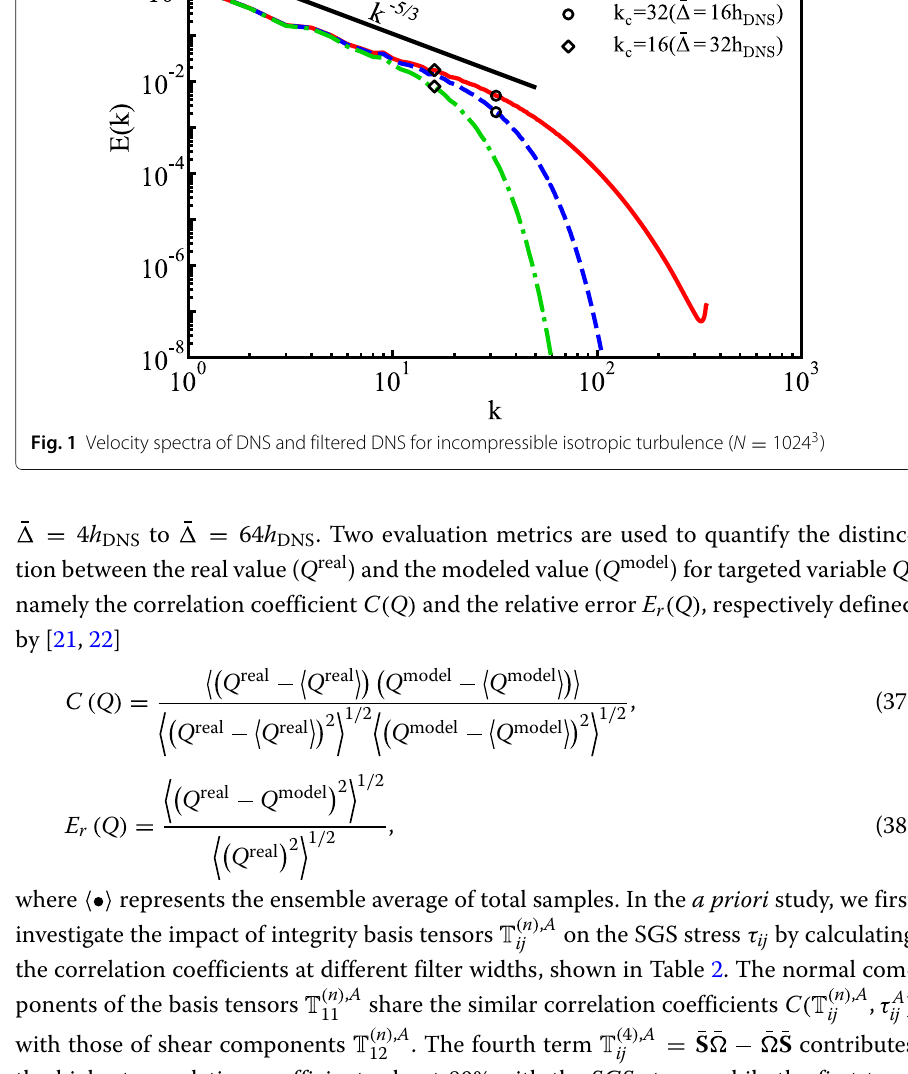
Table 2 Correlation coefficients C n , A